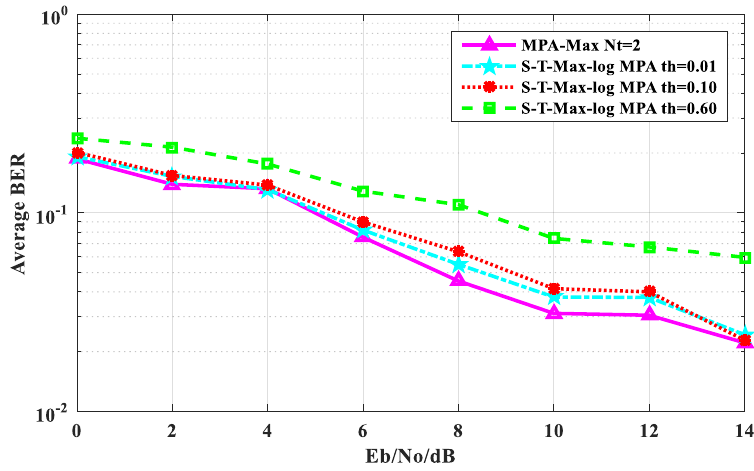
Figure 3. Comparison of average bit error ratio ( BER) performance when t max = 2.